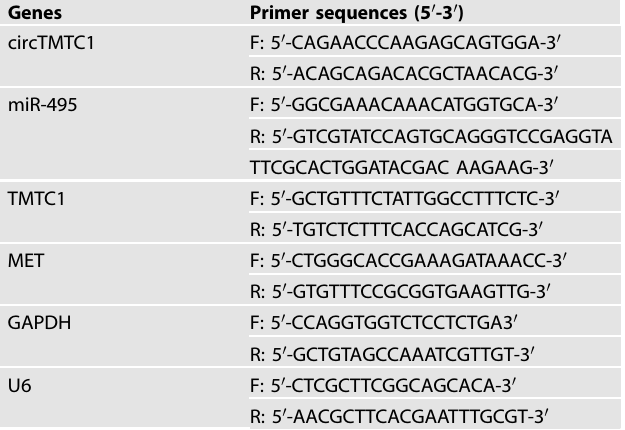
Table 1. The primers for qRT-PCR used in this